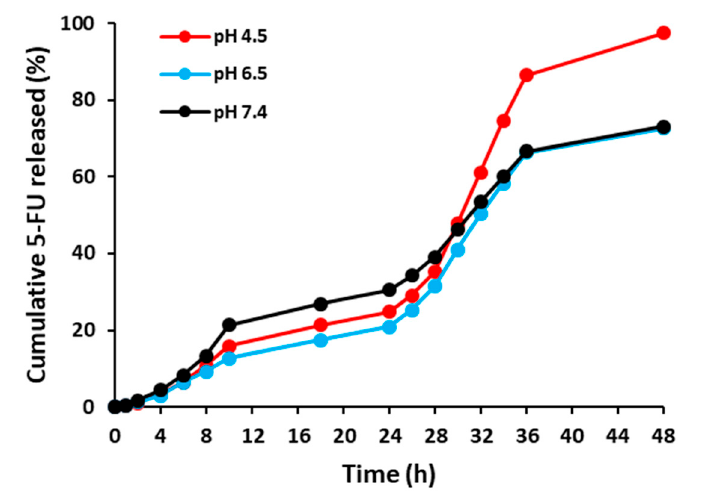
Figure 3. In vitro drug release profiles of 5-FU from CS-Mg 0.5 Co 0.5 Fe 2 O 4 -5-FU NPs.